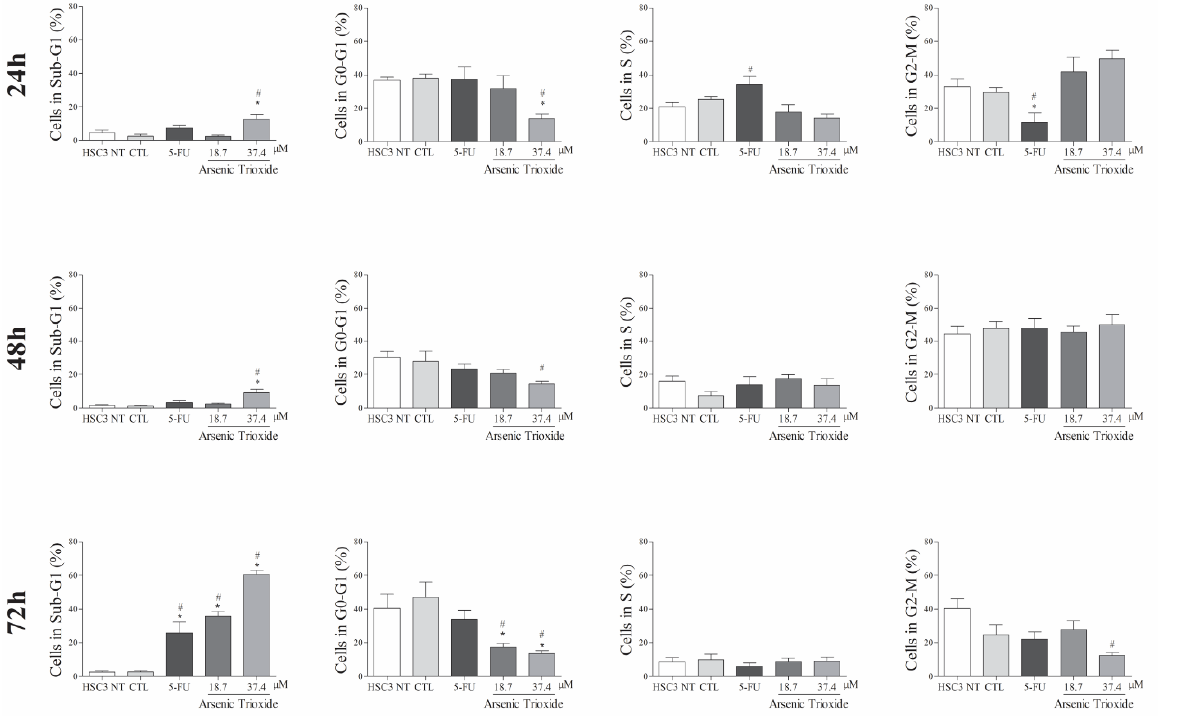
Figure 2. The effects of ATO on cell cycle phases (Sub-G1, G0-G1, S and G2-M) and internucleosomal DNA fragmentation in HSC3 cells at 24, 48 and 72 h of treatment. The vehicle was used (0.25% DMSO) as the negative control (CTL) and 5-FU (16.75 µM) as the positive control. The values correspond to means ± SEM from three independent experiments carried out in duplicate. Cellular debris was omitted from the analyses and 10,000 events were analyzed per sample. (*) p ≤ 0.05 when compared to the negative control (CTL), and (#) when compared to the HSC3 NT group (non-treated cells) by ANOVA (analysis of variance) followed by Student Newman-Keuls test.